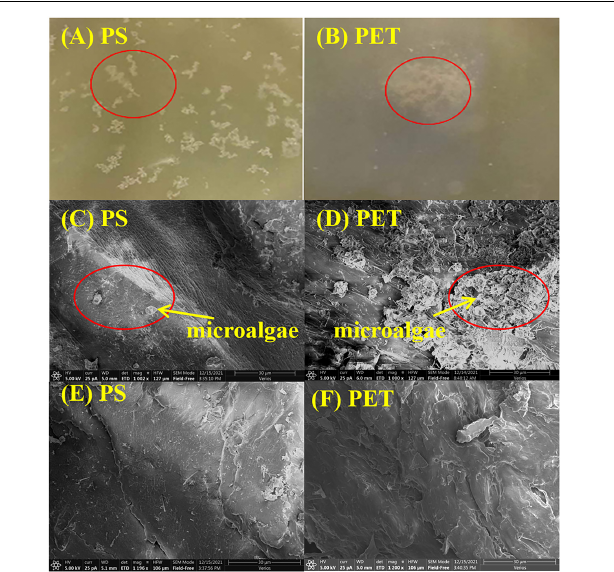
FIGURE 1 | Morphology of (A) mPS and (B) mPET in the culture of Chaetoceros muelleri observed by naked eyes; C. muelleri cells attached to (C) mPS and (D) mPET observed by SEM; SEM images of (E) mPS, and (F)